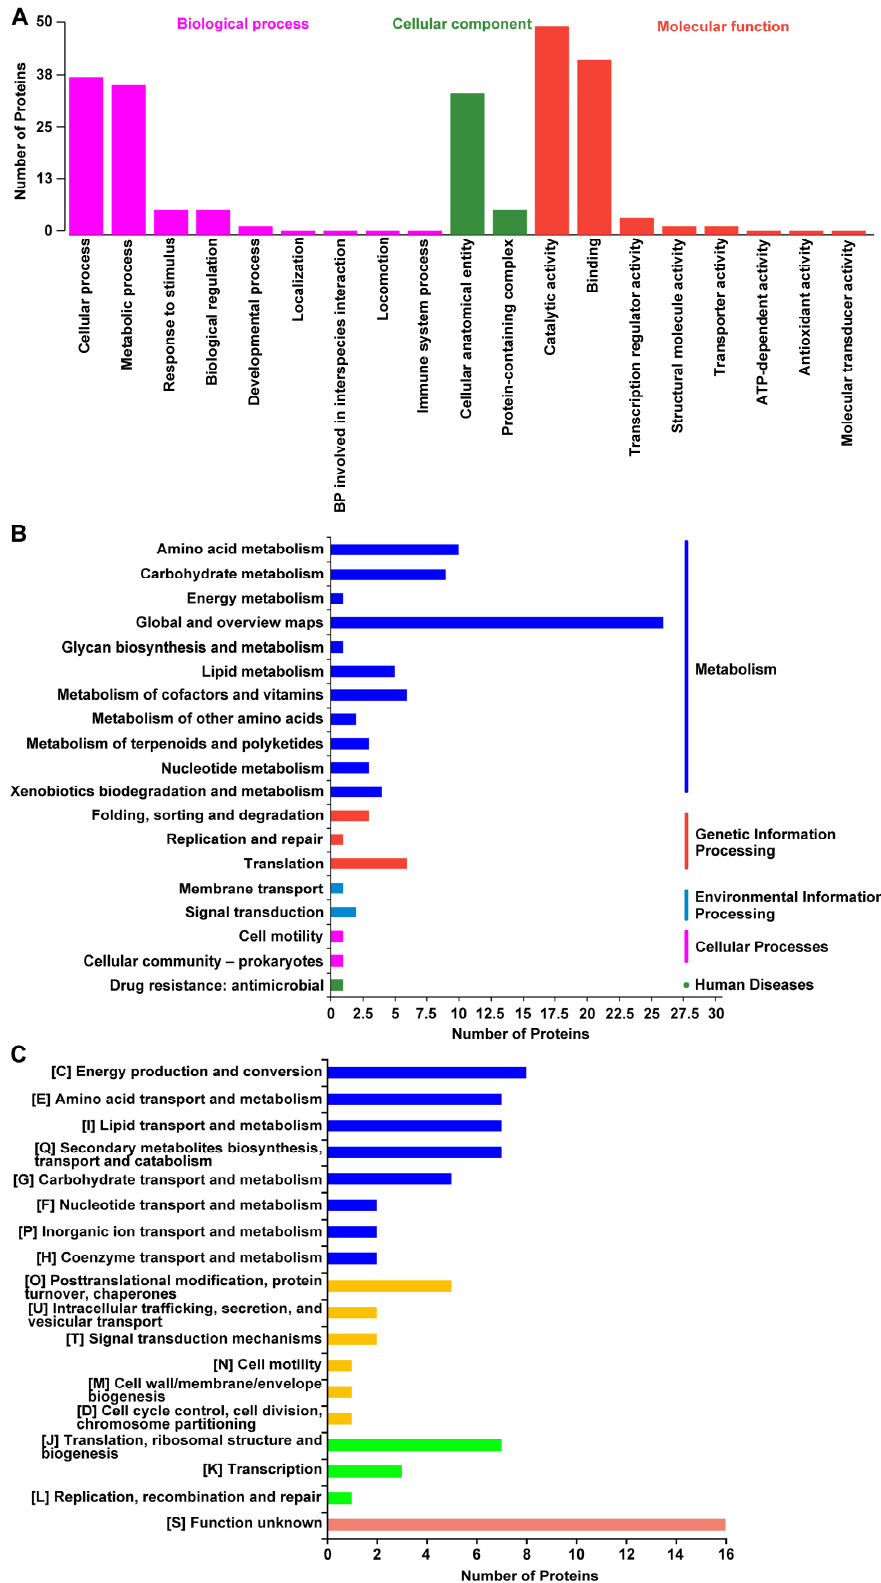
Figure 5. Function annotation results of DAPs in GO, KEGG and COG databases. ( A ) DAPs annotated in GO database. ( B ) DAPs annotated in KEGG pathway database. ( C ) DAPs annotated in COG